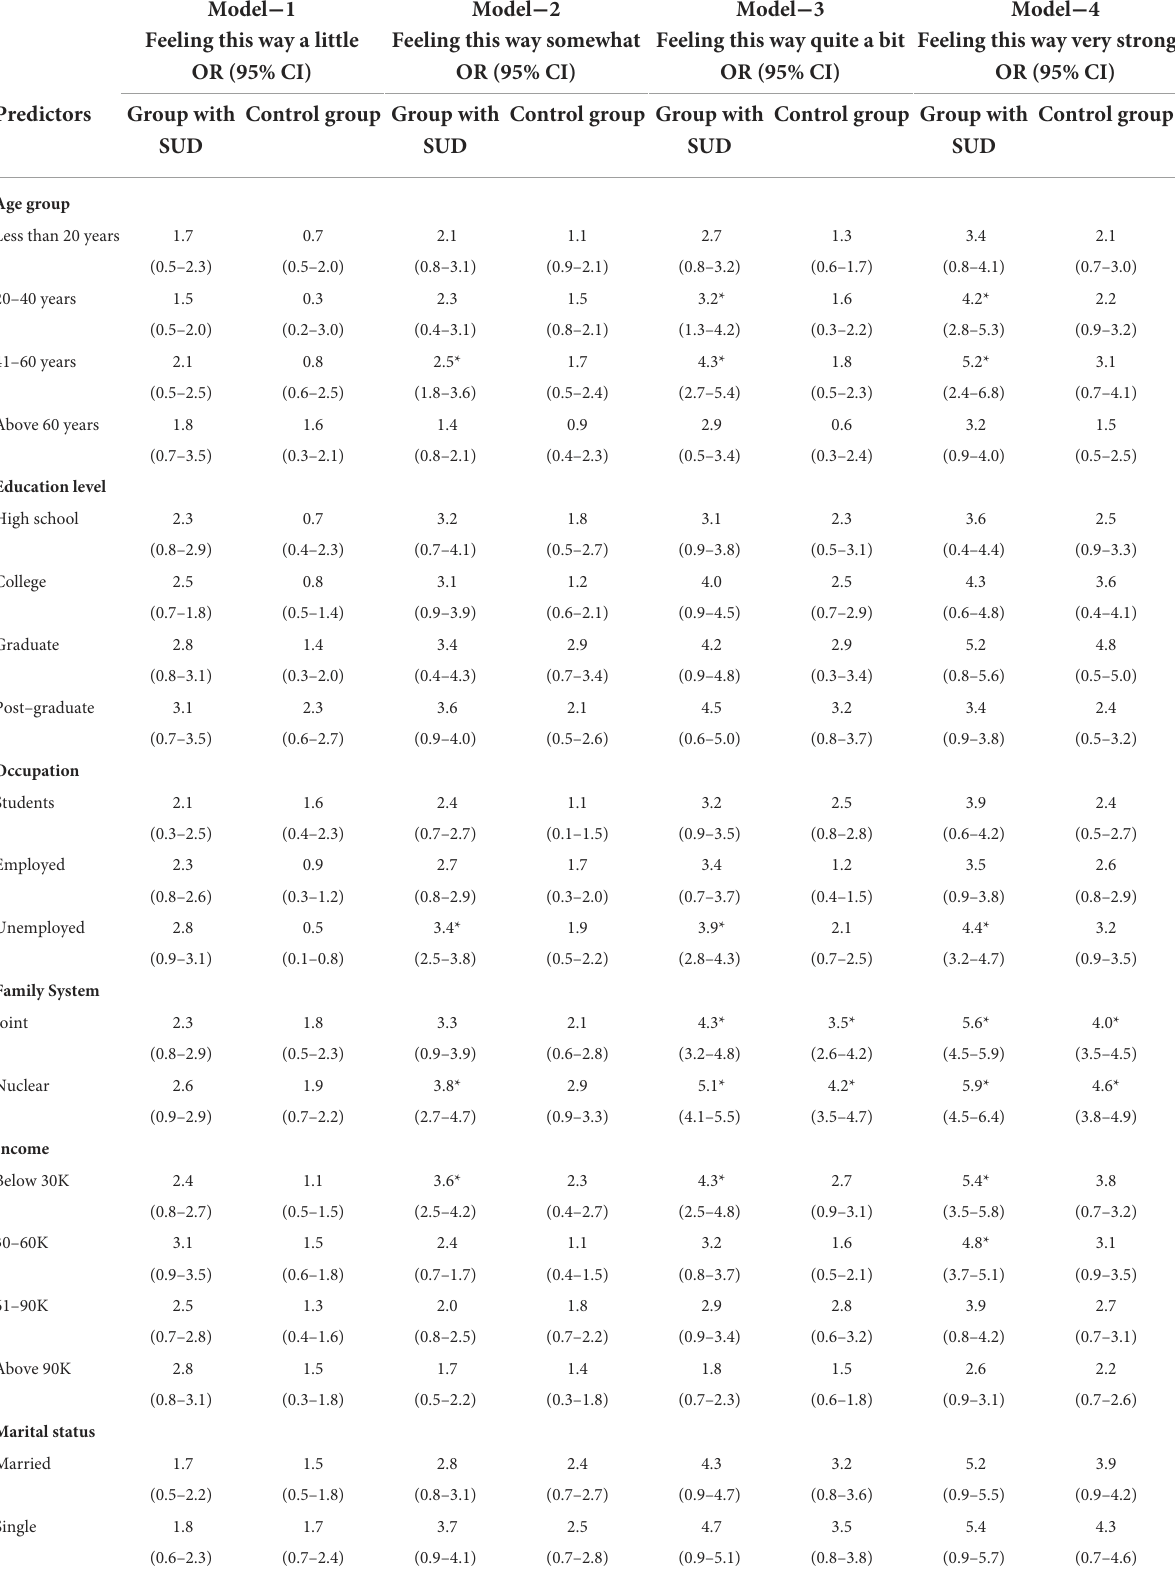
TABLE 4 Association of socioeconomic factors with different levels of shame in group with SUD and control